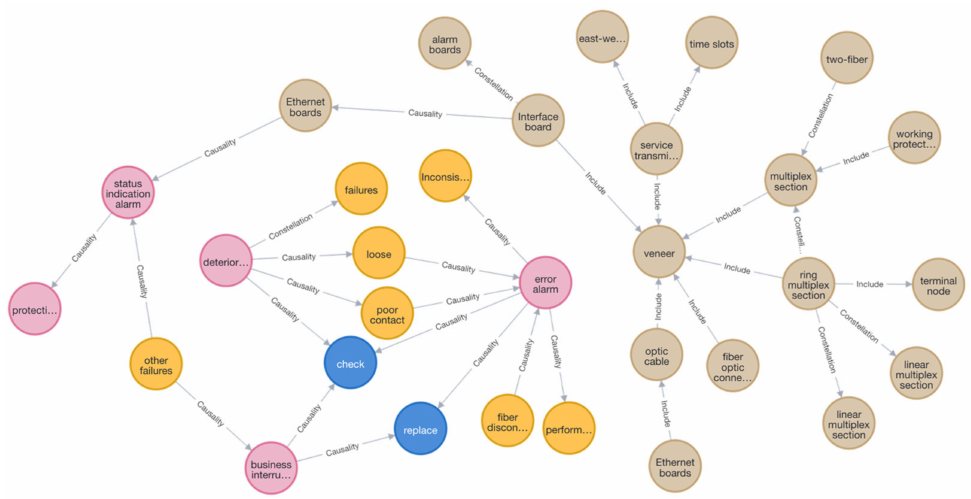
Figure 6. Knowledge graph of power communication